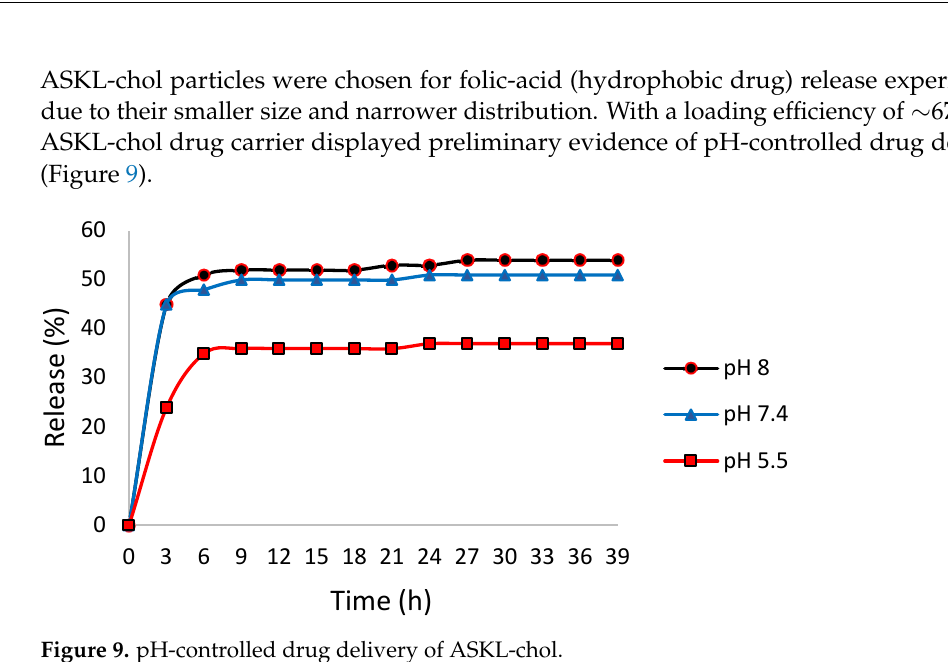
Figure 9. pH‑controlled drug delivery of ASKL‑chol. Figure 9. pH-controlled drug delivery of